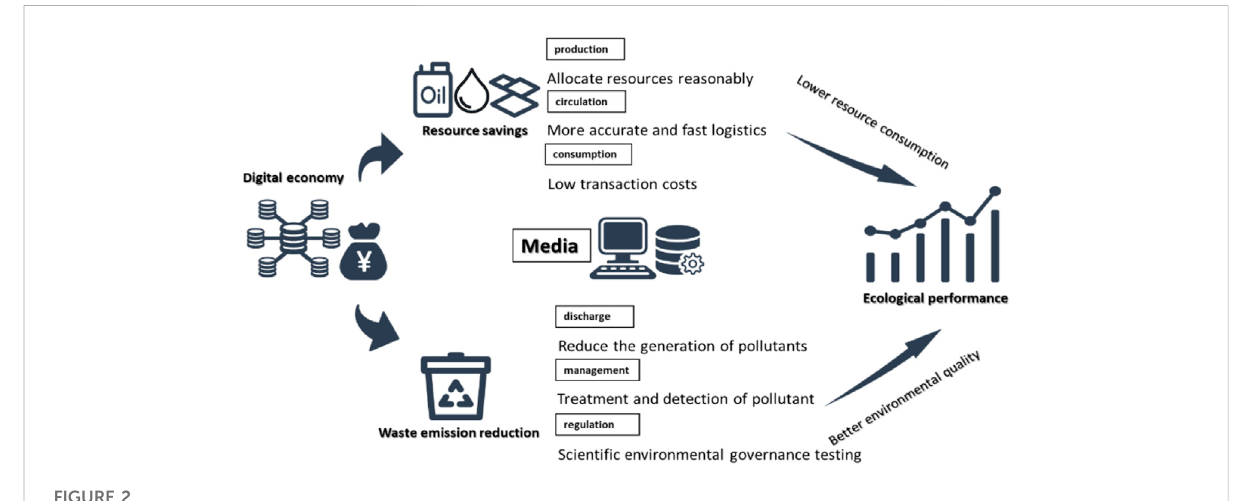
FIGURE 2 Mechanisms of the digital economy to ecological